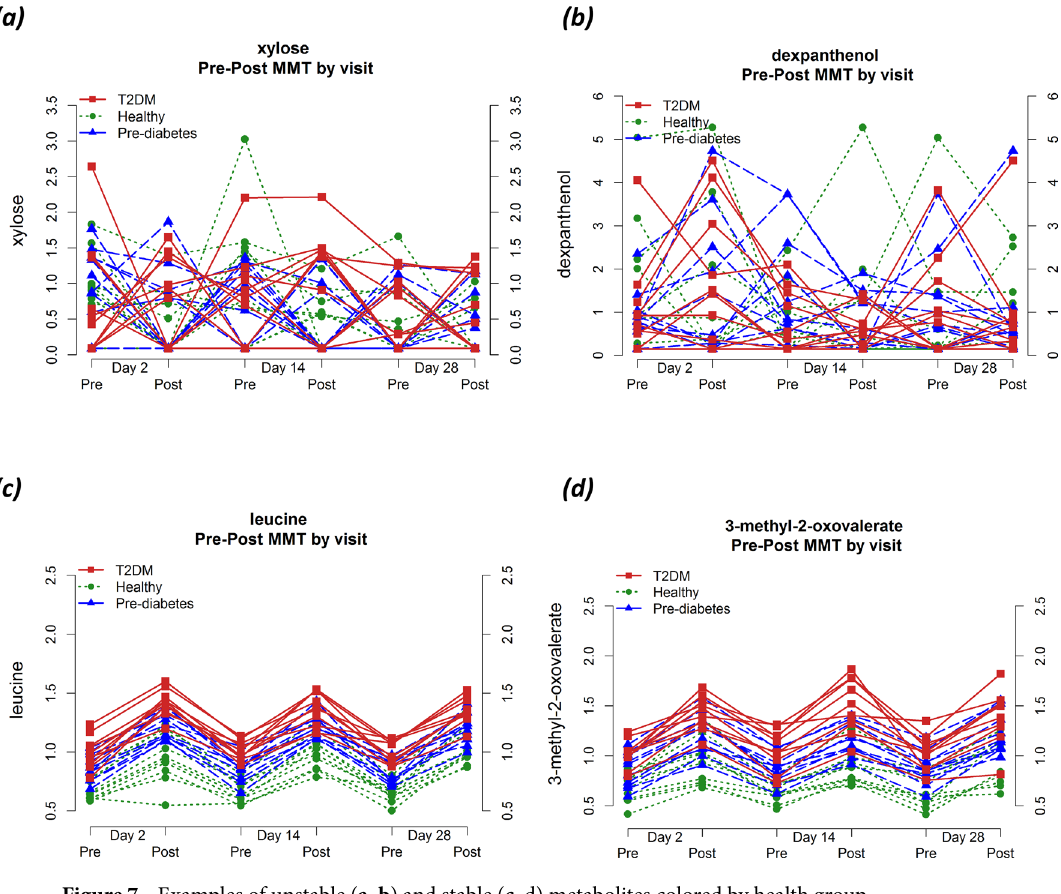
Figure 7. Examples of unstable ( a , b ) and stable ( c , d) metabolites colored by health